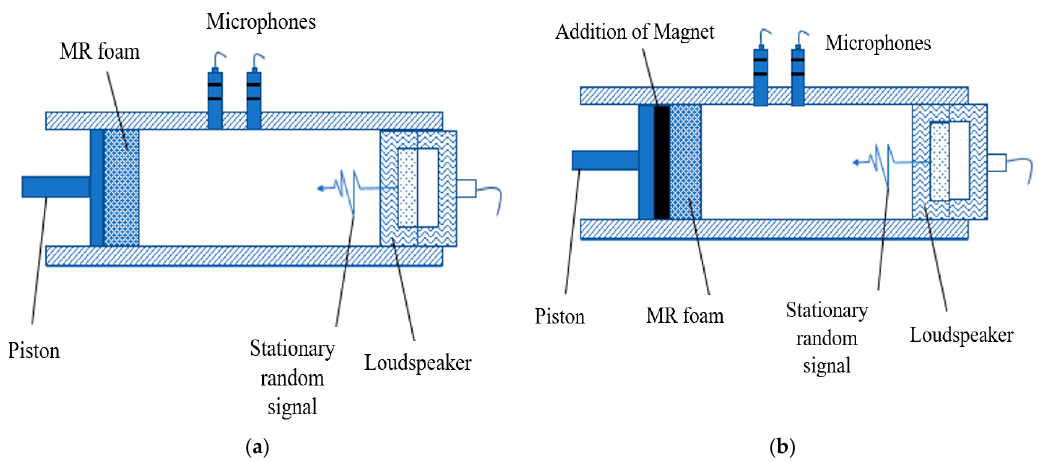
Figure 3. Schematic diagram of ( a ) off-state and ( b ) on-state set-up for acoustic absorption testing.